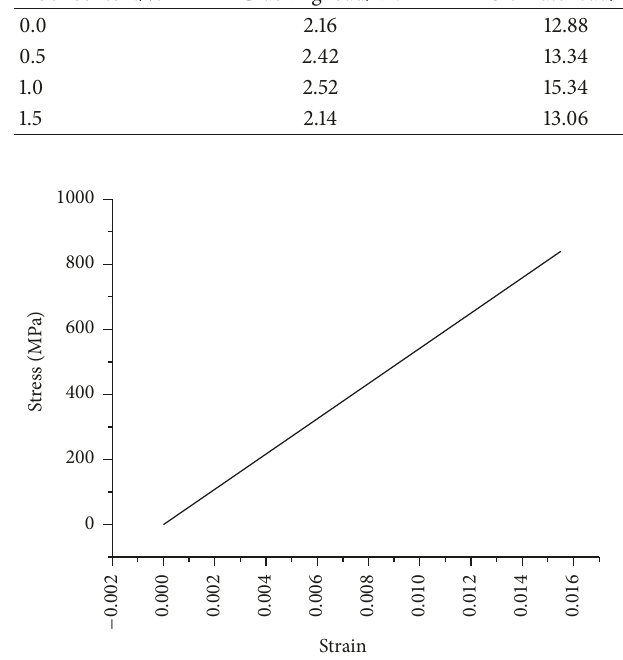
Figure 6: GFRP stress-strain constitutive